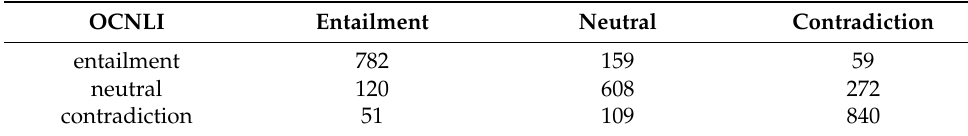
Table A2. Model performance. Confusion metric on OCNLI.